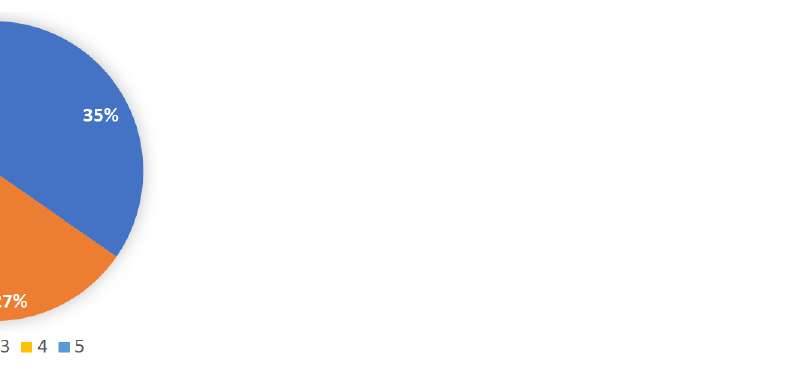
Figure 4. Previous familiarity with math e-learning software. Ranking from 1 (none) to 5